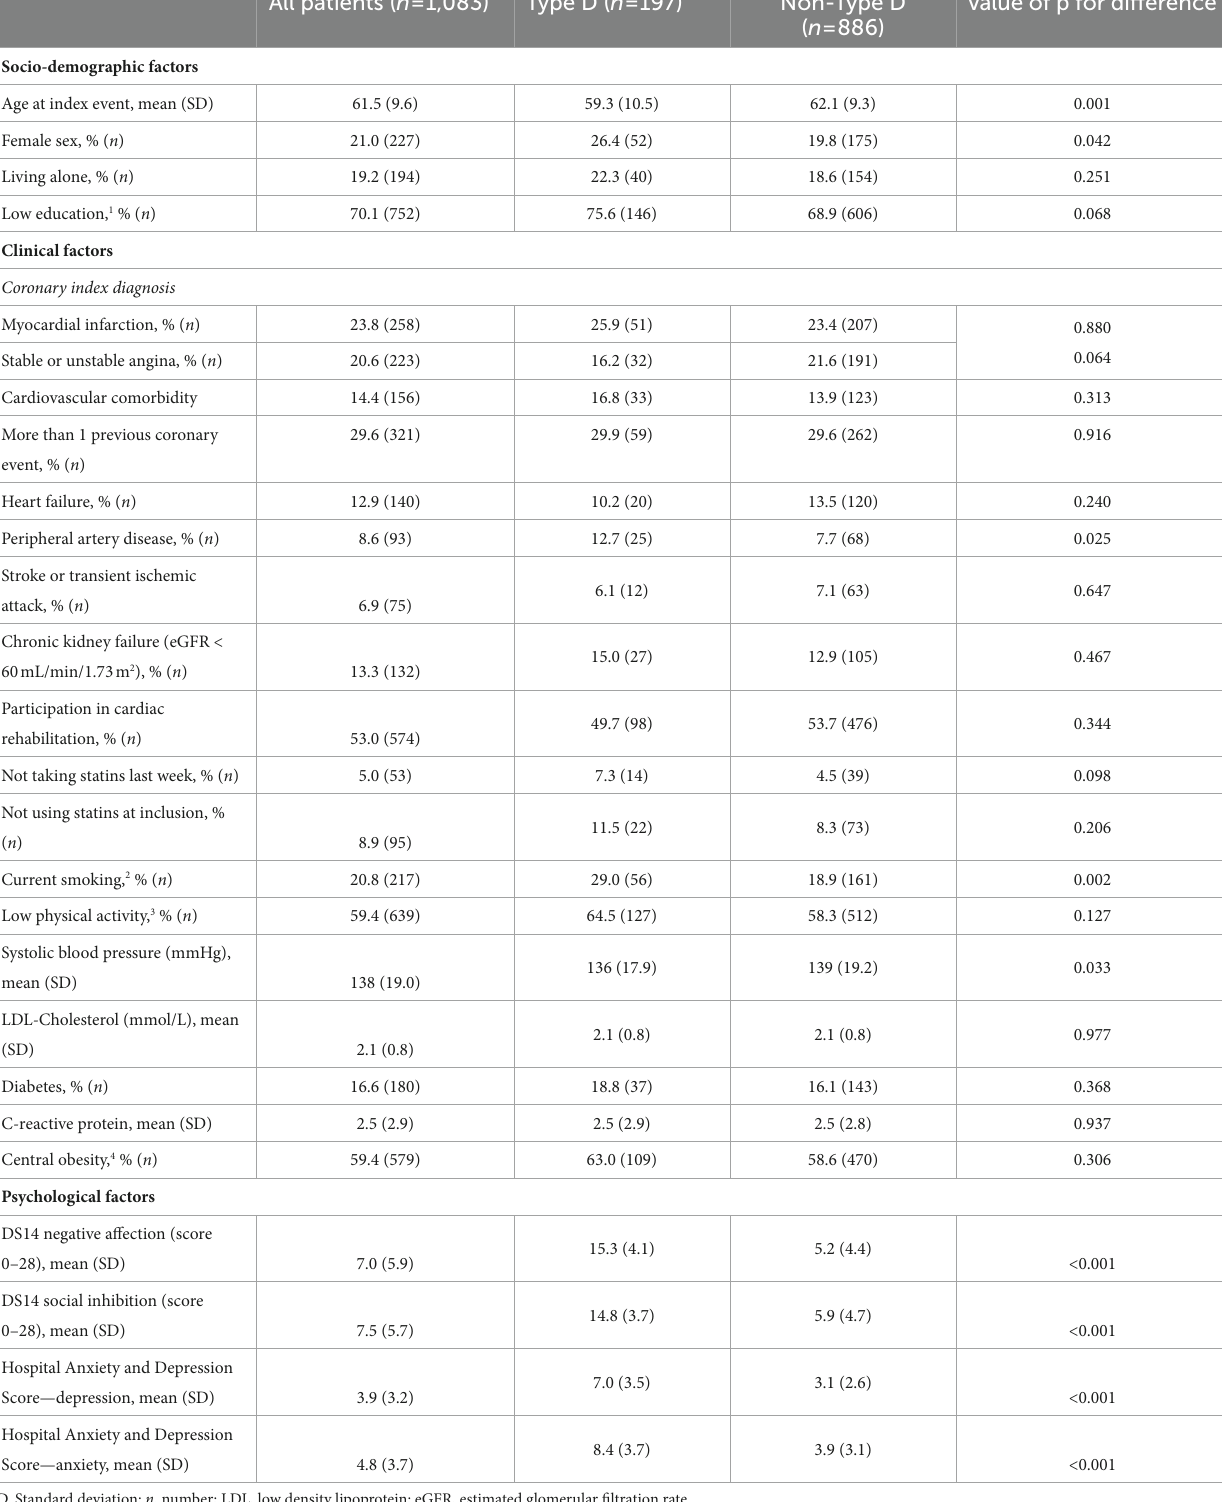
TABLE 1 Baseline characteristics of Type-D and non-Type D patients. All patients ( n = 1,083) Type D ( n = 197) Non-Type D